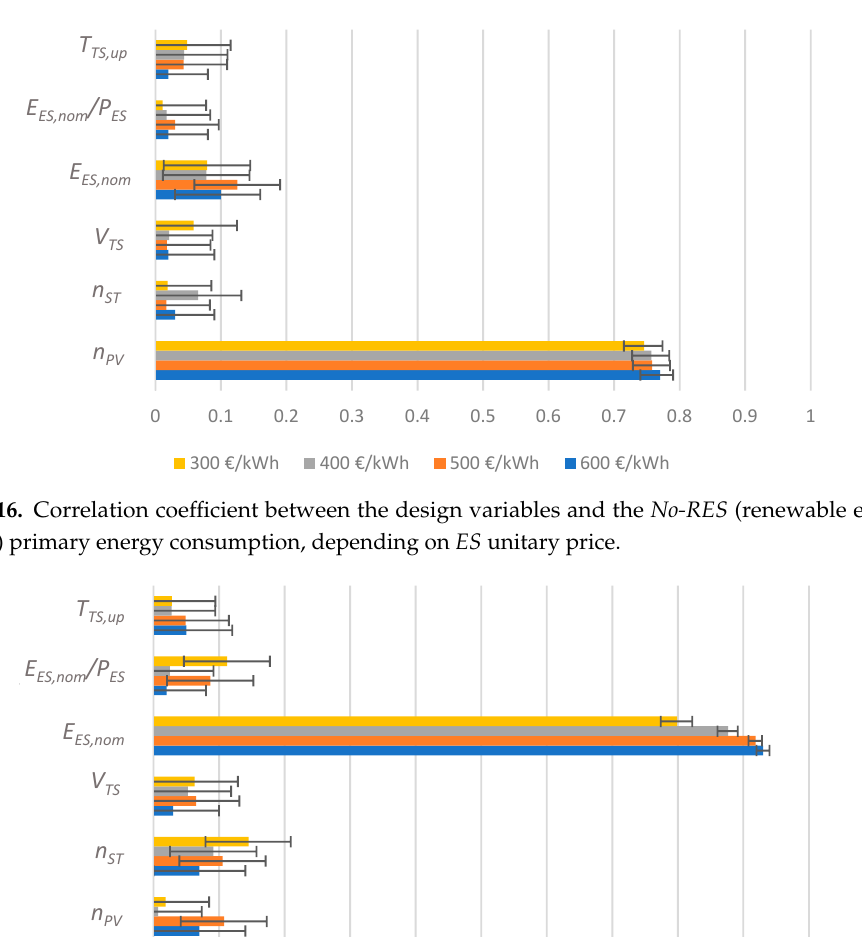
400 Figure 19. Ratio between the nominal electrochemical storage capacity and the PV capacity depending on ES unitary price.